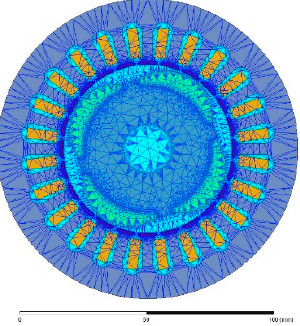
Figure 8. Finite element model to calculate electromagnetic force.